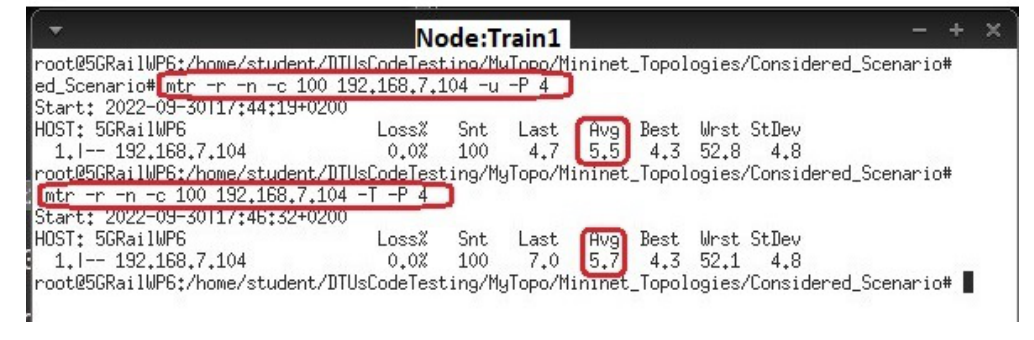
Figure 28. Latency test from Train1.